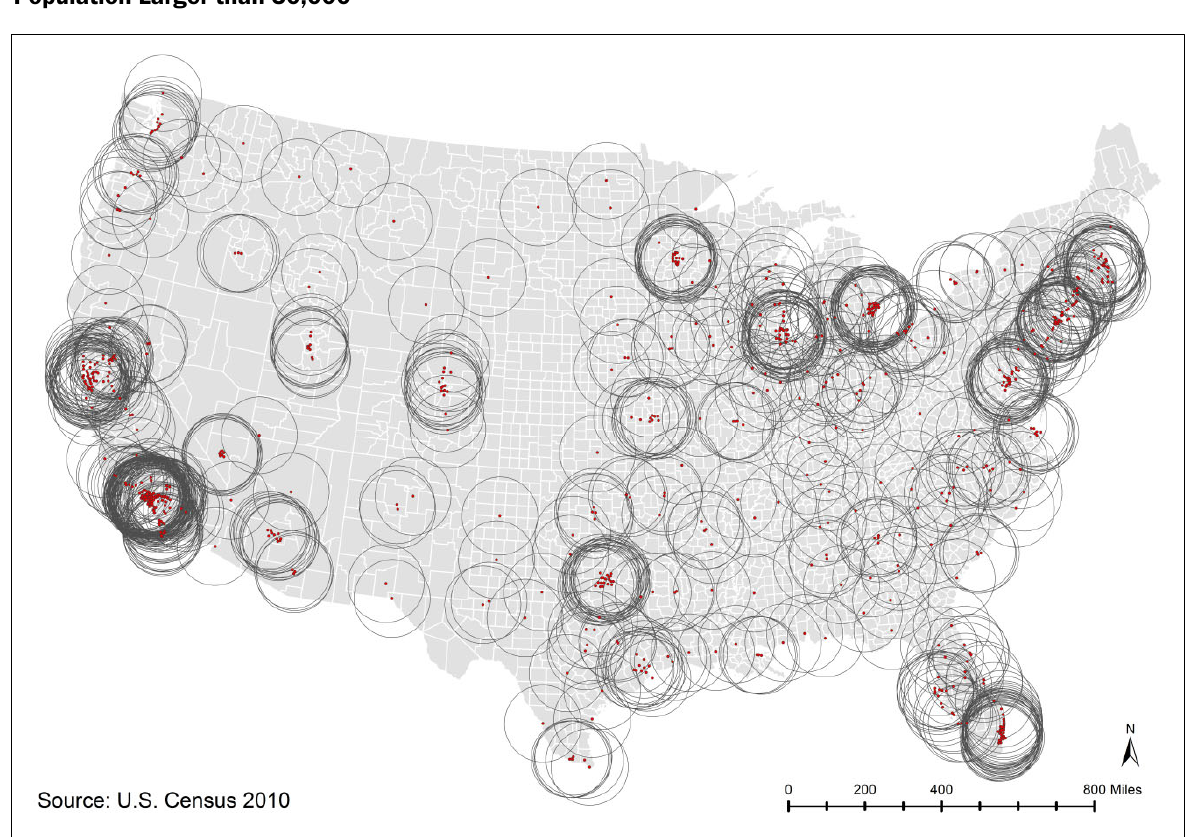
Figure 1. Local Foodsheds Delineated by a 100 Mile Radius Around U.S. Cities with Population Larger than